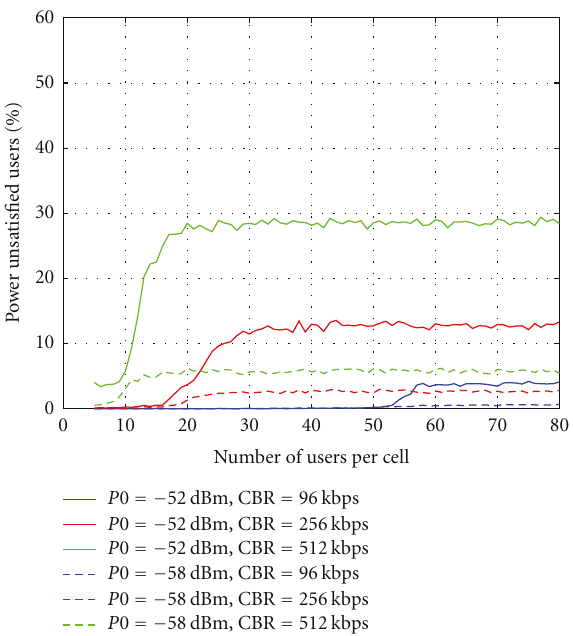
Figure 5: Number of unsatisfied users due to power limitation.